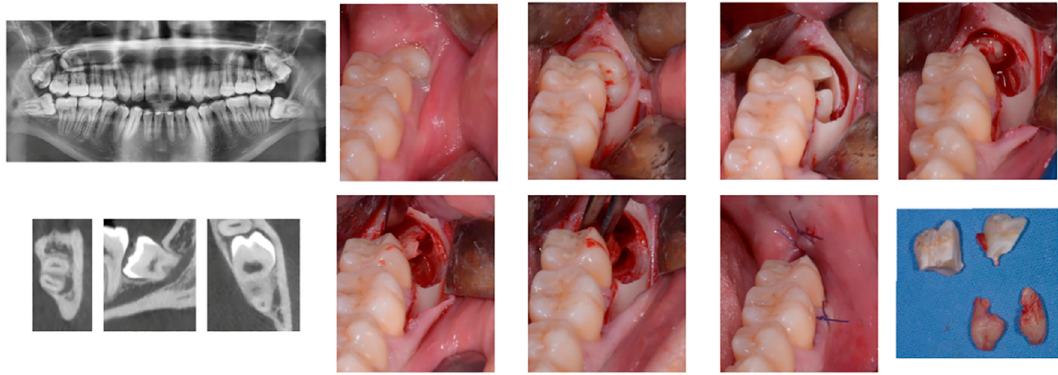
Figure 11. Access to the third molar was performed by a mucoperiosteal flap and a vestibular osteotomy with a fissure burr under continuous irrigation. If necessary, a crown and/or root sectioning was performed using the same fissure burr. After extraction the alveolus was inspected, curetted for granulation tissue removal, and irrigated with sterile saline solution. A 4/0 monofilament nylon suture was used to close the wound without tension. The choice of the third molars was done since their extraction represents a difficult and complex task to be carried out in the rear part of the mouth where large occlusions require, in many cases, the surgeon to keep uncomfortable positions for long periods. Due to the presence of many nerves in the operation zone, high attention must be kept for the whole intervention, increasing the stress and the muscular tightening of the practitioner.